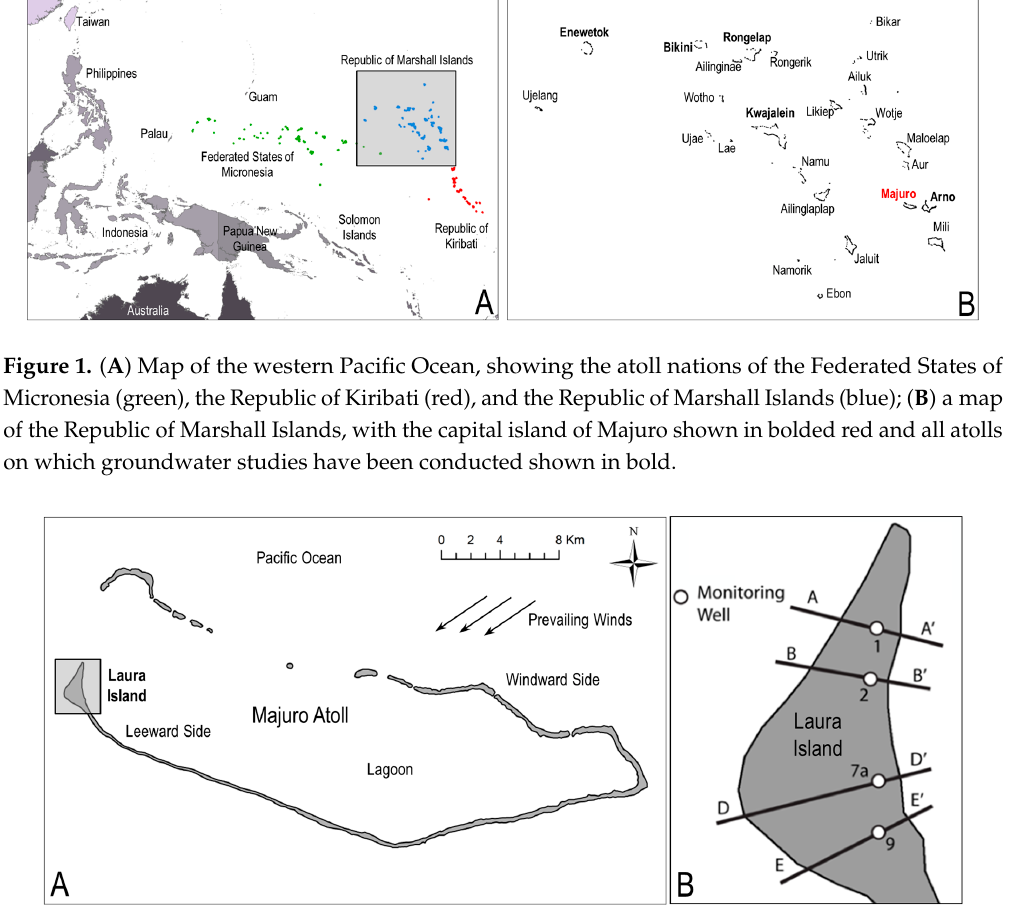
Figure 2. ( A ) Majuro Atoll, showing the direction of prevailing winds and the windward and leeward sides of the atoll; and ( B ) a close ‐ up map of Laura Island and the location of the four monitoring wells. Data from the monitoring wells during the 1998–1999 El Niño drought are used in this study to corroborate the algebraic model for drought periods.